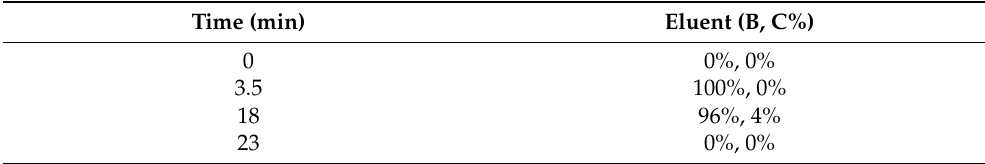
Table 3. The gradient elution program for HPLC analysis of catechu extracts. Time